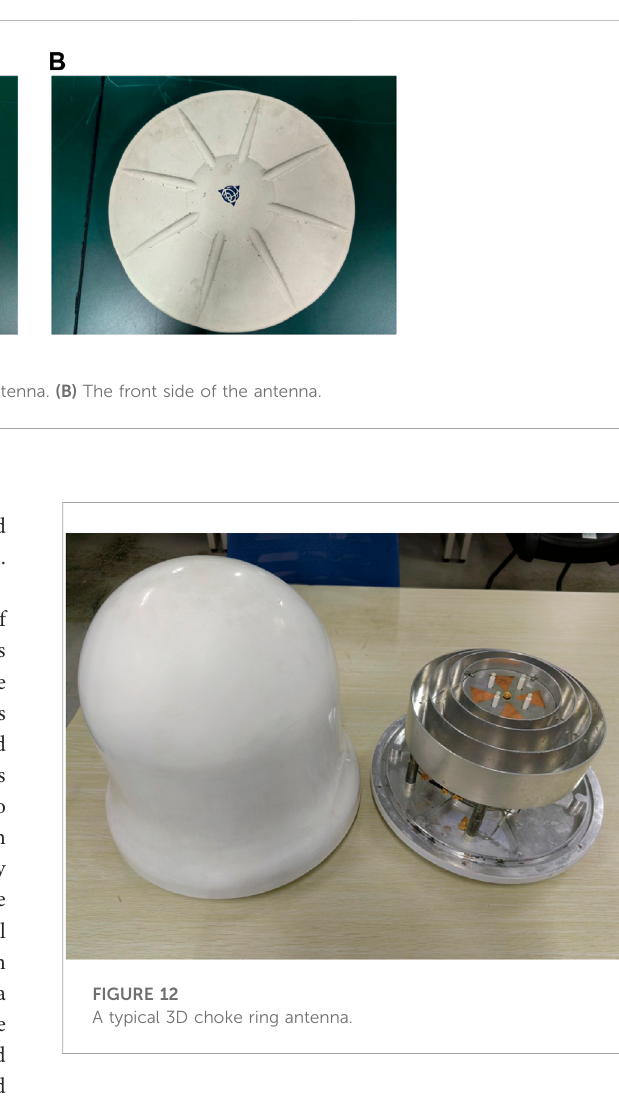
algorithm — this algorithm in alleviating the short delay